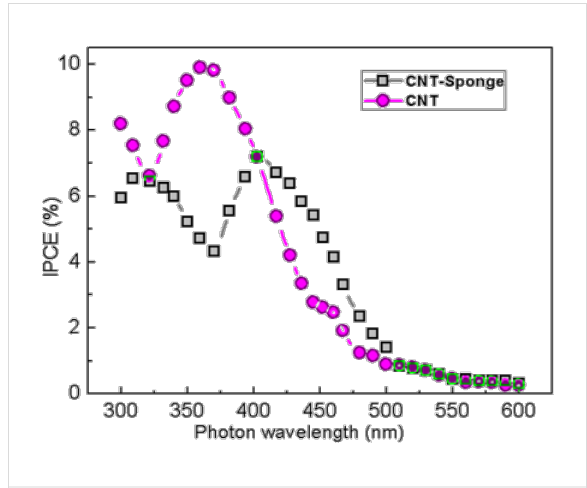
Figure 8: Incident-photon-to-current efficiency (IPCE, %) obtained from a MWCNT 2D film (purple circles), and for a CNT-sponge sample (grey squares) as function of incident photon